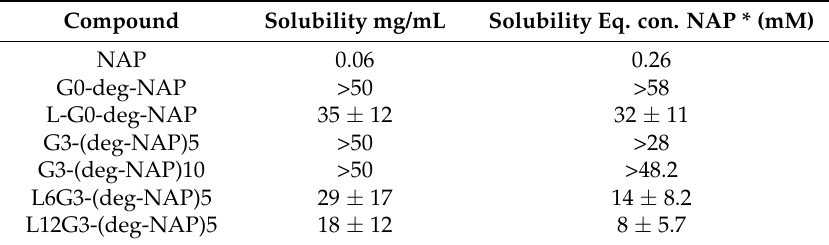
Table 3. The solubility (pH 1.2) naproxen and its conjugates at 37 ◦